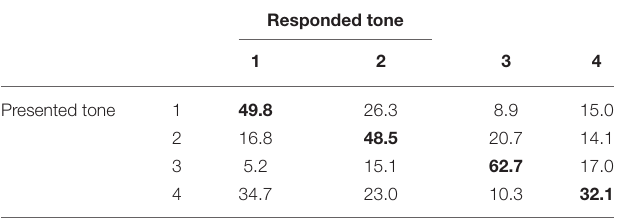
TABLE 1B | Confusion matrix for tone (percentage correct) in non-musicians.